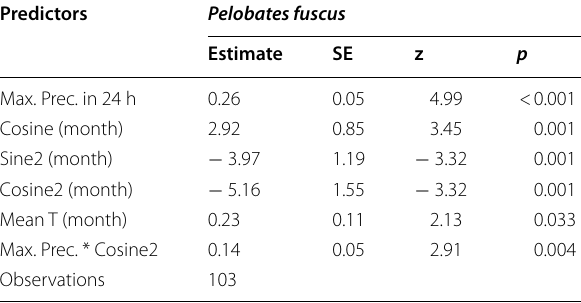
Table 1 Results for count